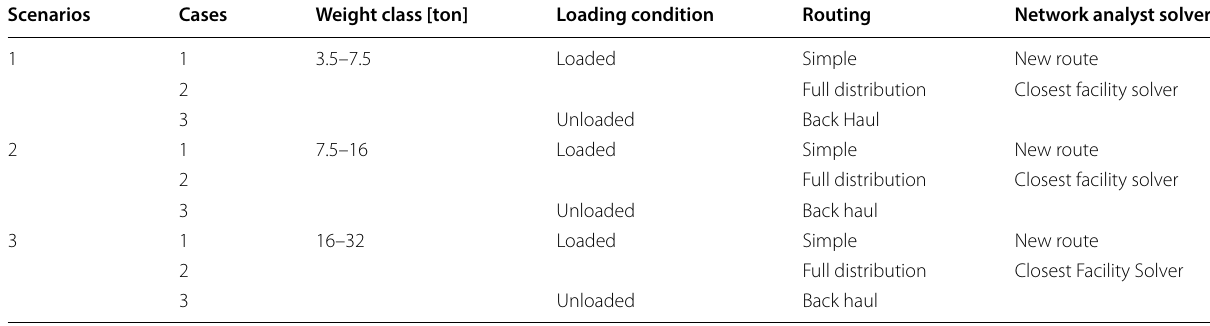
Table 4 Scenario implementation for the methodology